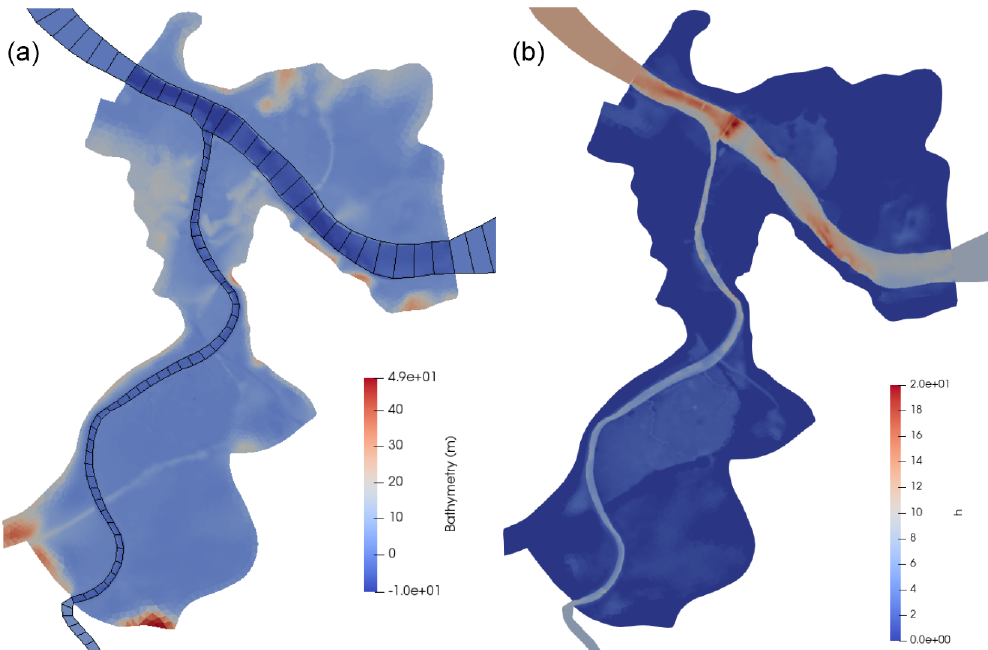
Figure 16. Zoom on the Bayonne area (green area in Fig. 15) using the 1D-like and 1D–2D approaches. Manning values are homogeneous throughout the network and floodplains at 0 . 05sm − 1 / 3 . (a) Bathymetry in 1D-like and 2D meshes. The 2D area has 66982 cells, and the coupled 1D-like reaches account for 1342 cells. The south, east and west interfaces, respectively, feature 6, 18 and 14 2D cells. The exclusively 1D-like mesh contains 1409 cells. (b) Simulated water height for the 1D–2D model for a sample flooding event (low